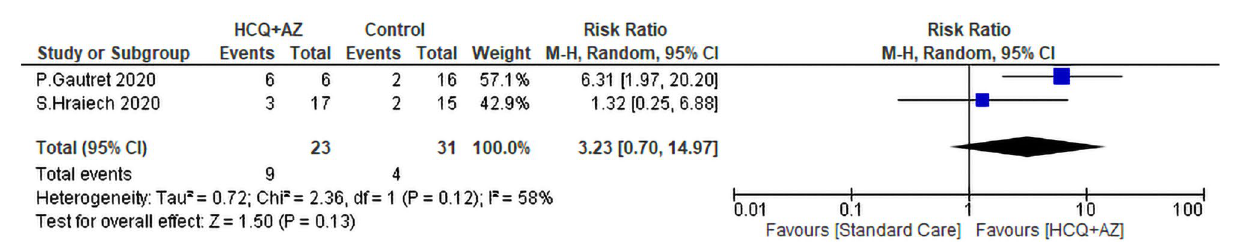
Figure 8. The virological cure rate of Hydroxychloroquineand azithromycin versus standard care.